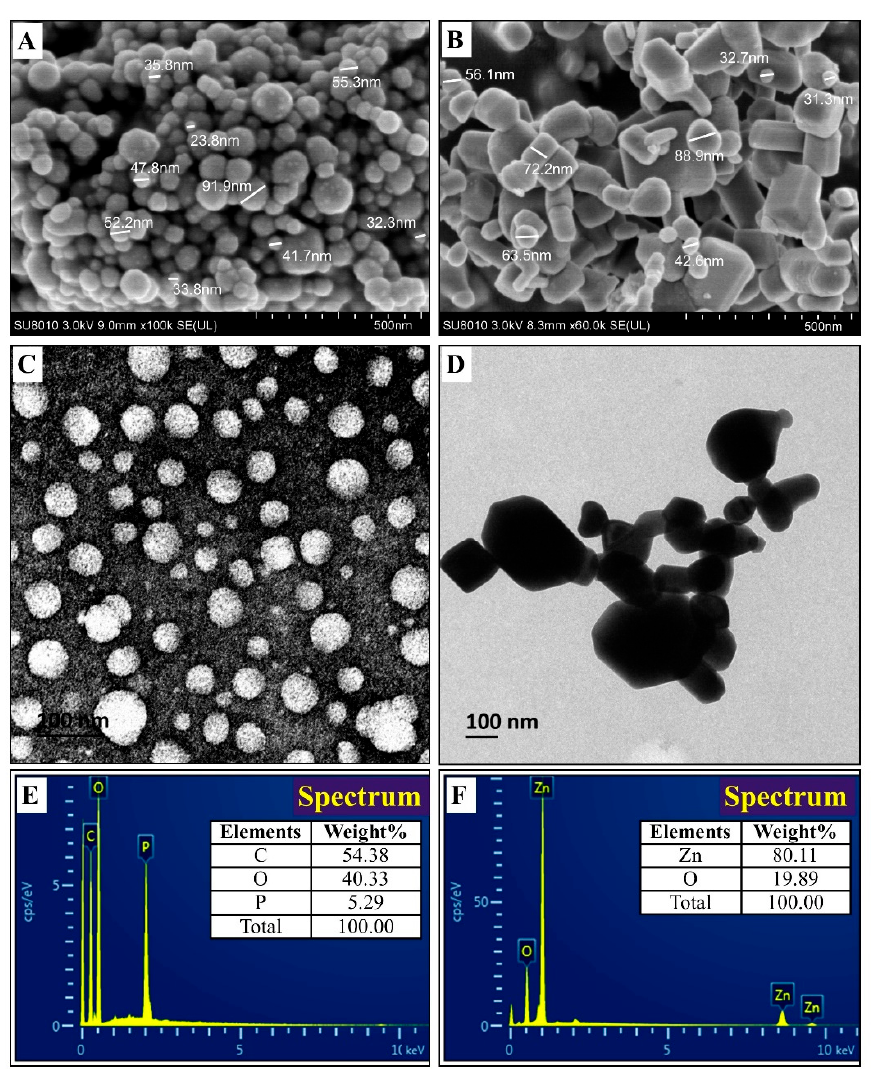
Figure 3. Characterization of the bio-synthesized by SEM analysis: ( A ) CSNPs; ( B ) ZnONPs, TEM analysis; ( C ) CSNPs; ( D ) ZnONPs and EDS; ( E ) CSNPs; ( F ) ZnONPs.